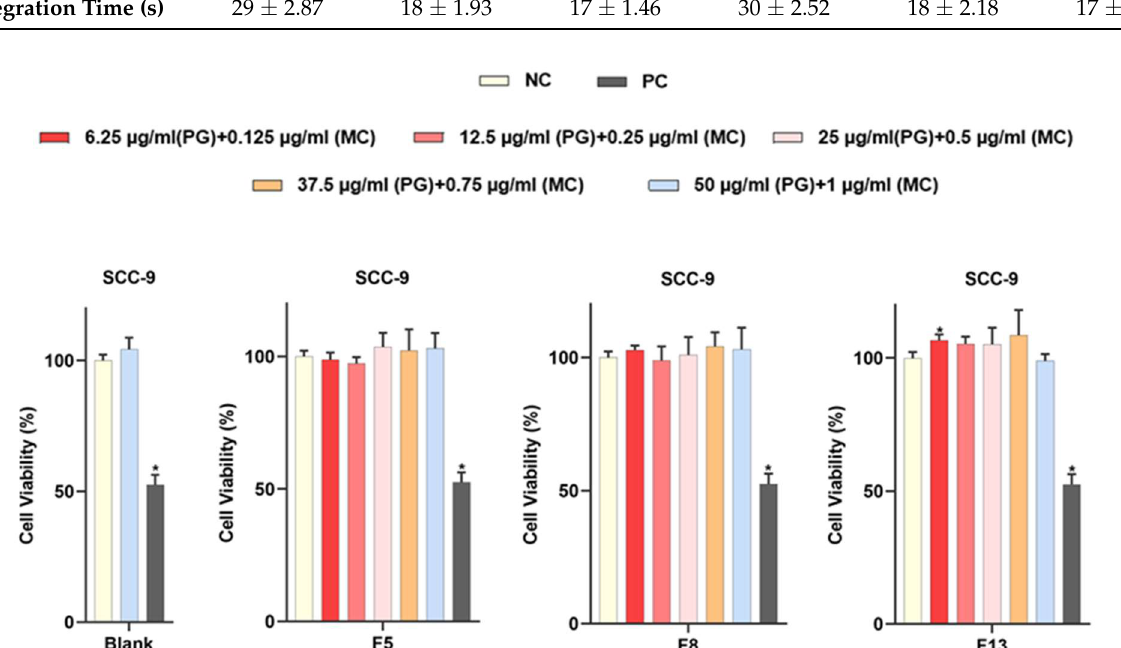
Figure 9. Cell viability test results of Blank, F5, F8, and F13. Negative control (NC) cells were grown to contain medium only. Positive control (PC) cells were treated with 10% DMSO. Statistical significance is shown as * ( p < 0.05) compared to the NC.